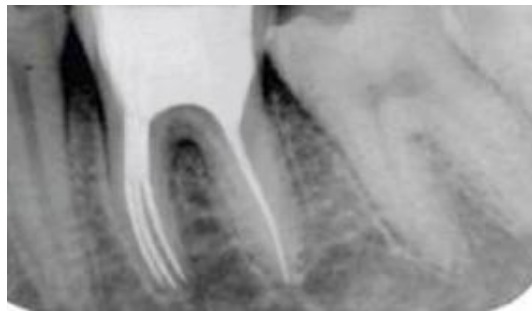
Figure 5: Post-obturation